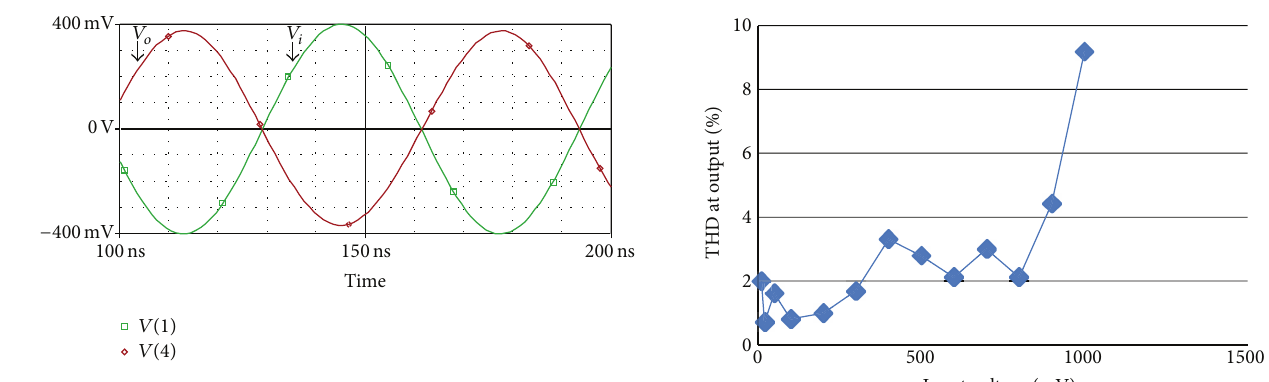
Figure 7: Input/output waveforms at 15.92 MHz.